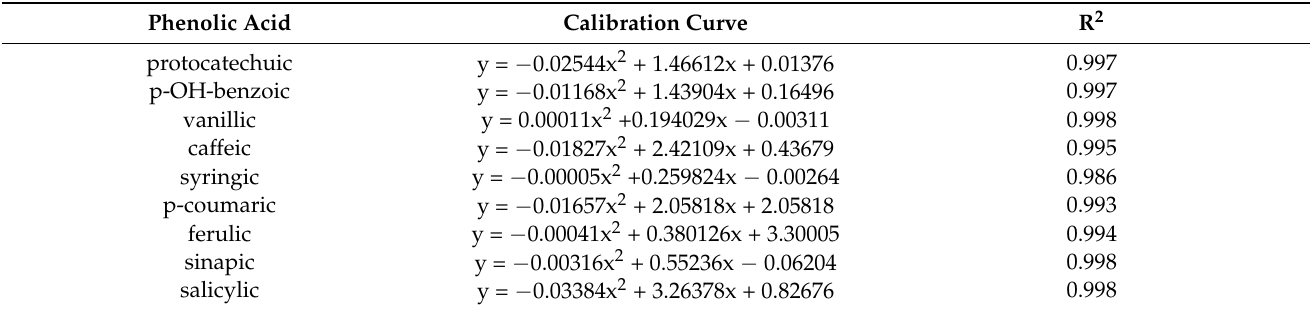
Table 10. Parameters of the calibration curve for nine different phenolic